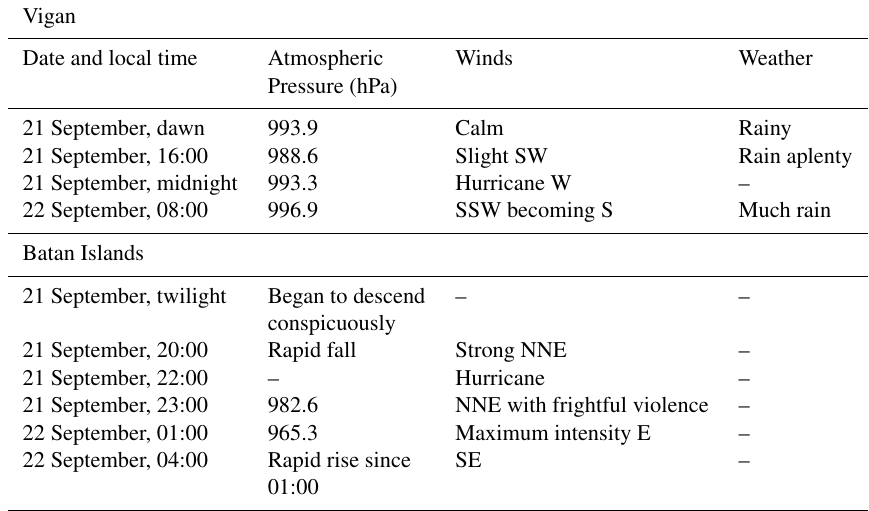
Table 2. Chronological summary of weather observations at Vigan and the Batan Islands (extracted from Sect. S1) during the passage of Typhoon